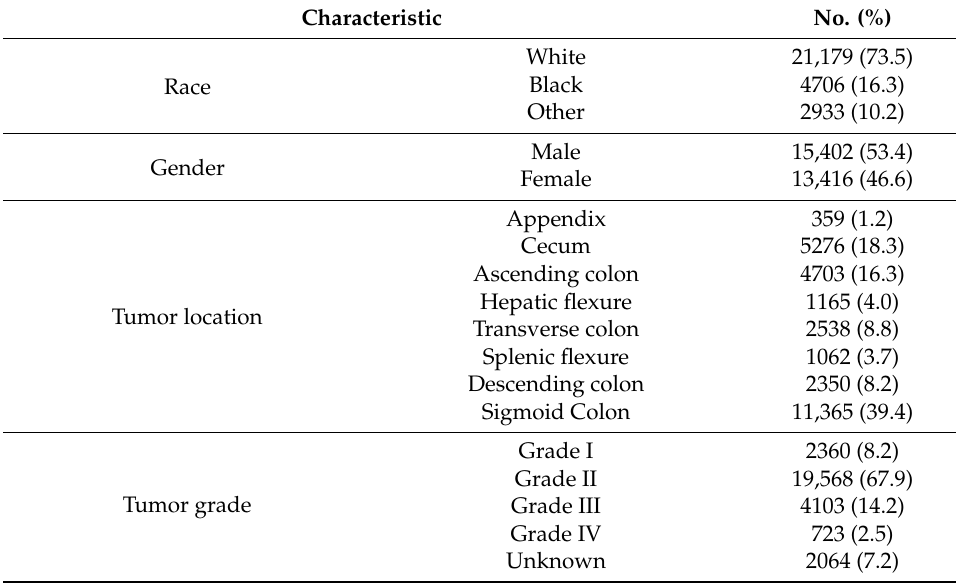
Table 1. Baseline characteristics of colon cancer patients included in our